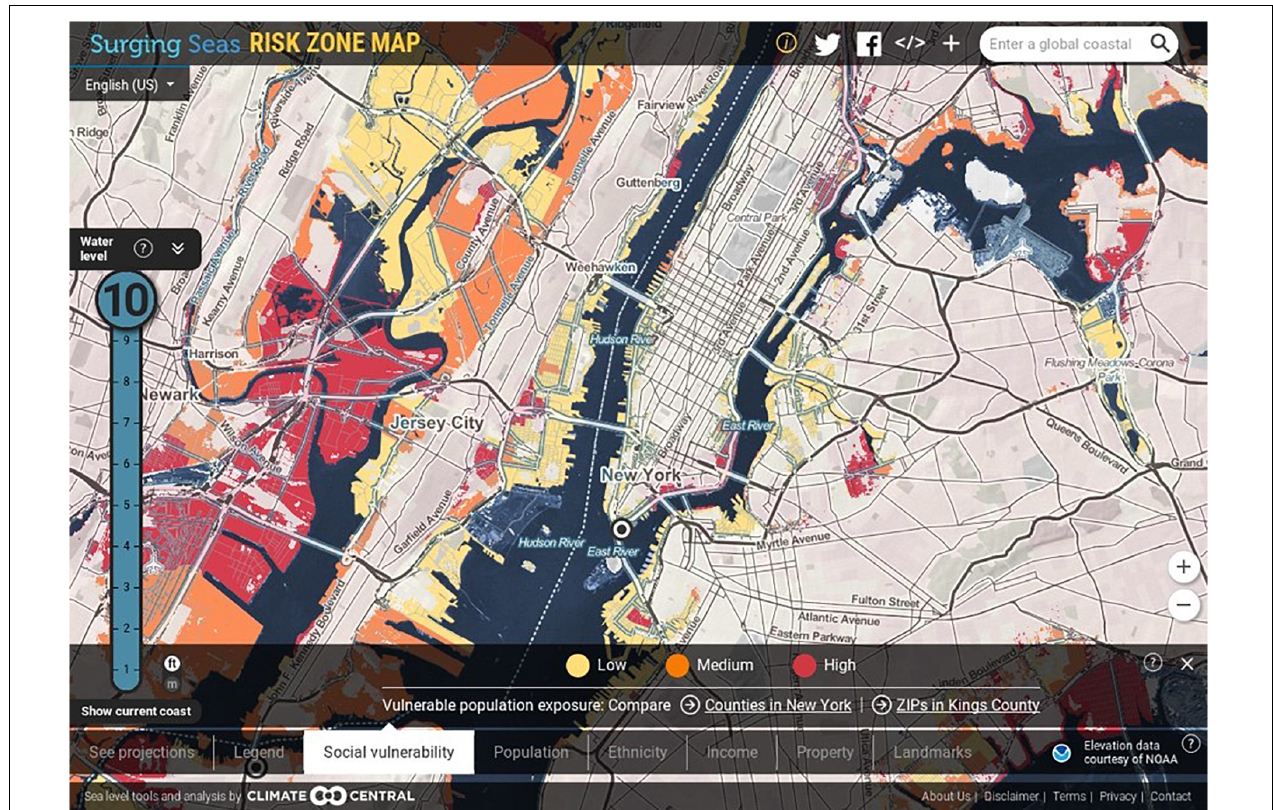
FIGURE 2 | Predicted social vulnerability of communities centered around New York City and Newark, New Jersey to a 10-foot storm surge or sea level rise. From “Surging Seas” risk zone maps produced by Climate Central . Orange, medium vulnerability; red, high vulnerability. Note the high level of vulnerability of several New Jersey